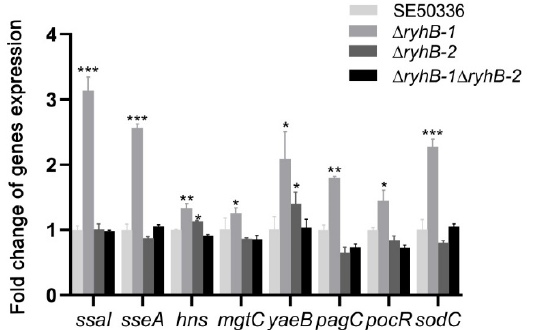
Figure 4. Expressions of survival-associated genes from intracellular bacteria infecting HD11 macrophages. HD11 macrophages were infected with the WT strain SE50336, the mutants ∆ ryhB-1 , ∆ ryhB-2 , and ∆ ryhB-1 ∆ ryhB-2 . Total RNA was extracted at 8 hpi and the relative expressions of survival-associated genes were determined using qRT-PCR. The expression values were normalized to the levels of the reference gene gyrA . Values on y -axis were represented as fold change in gene expression relative to SE50336. All assays were performed in triplicate. * p < 0.05, ** p < 0.01, *** p < 0.001, one-way ANOVA.